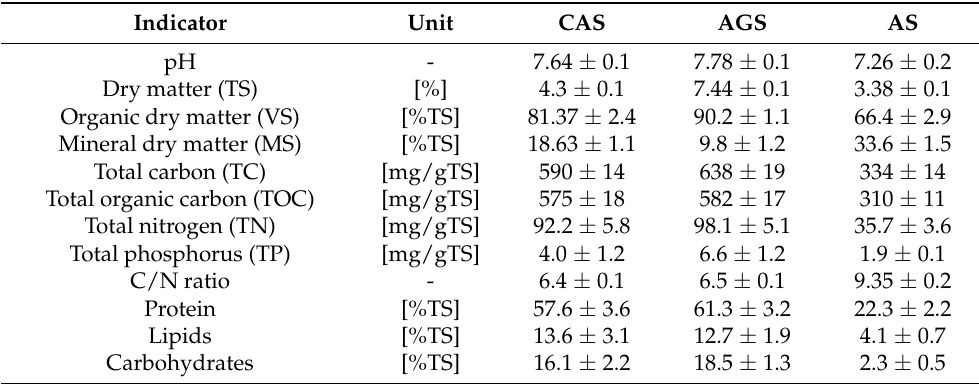
Table 5. Characteristics of CAS, AGS, and AS used in the